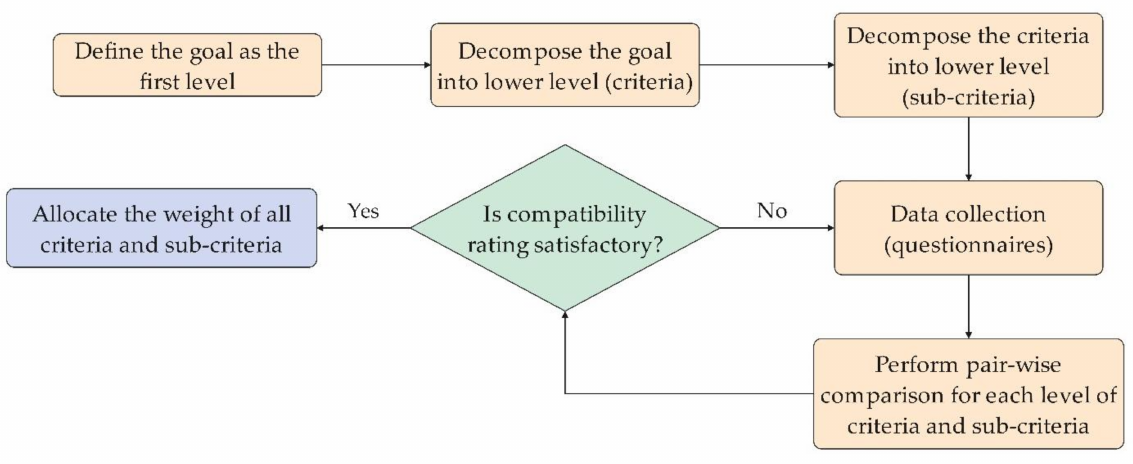
Figure 4. The flow chart of AHP used in this